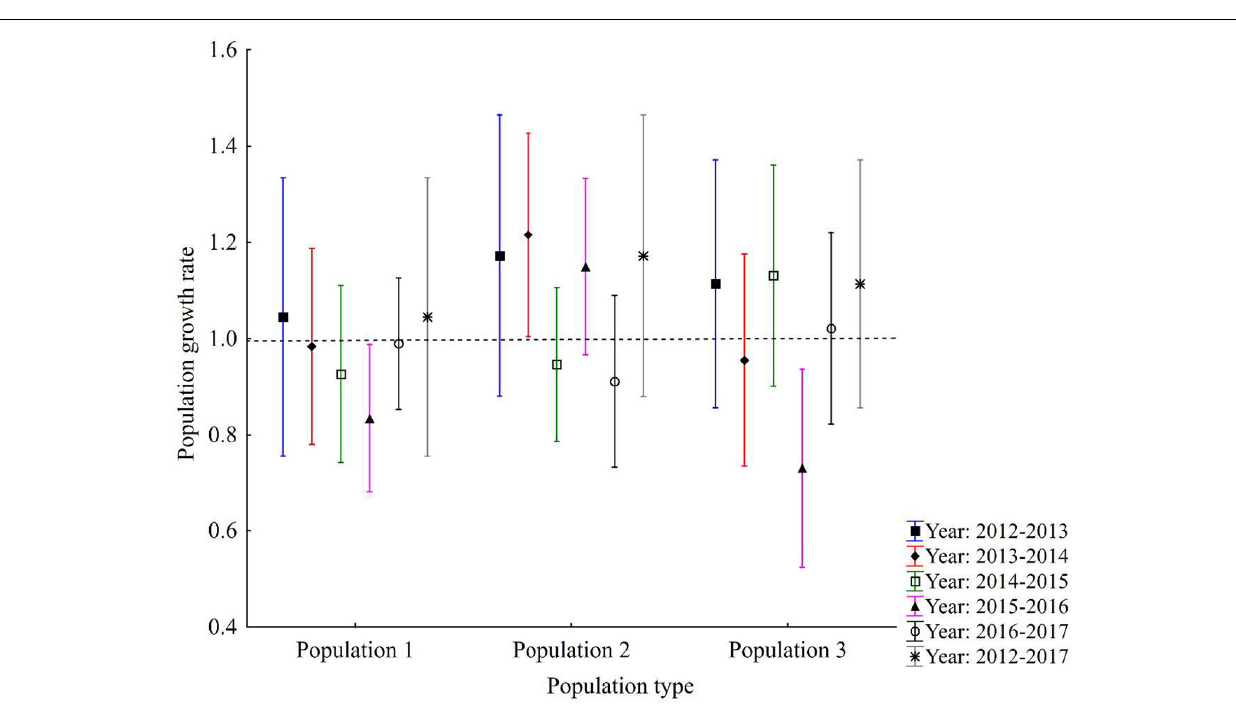
Frontiers in Ecology and Evolution |